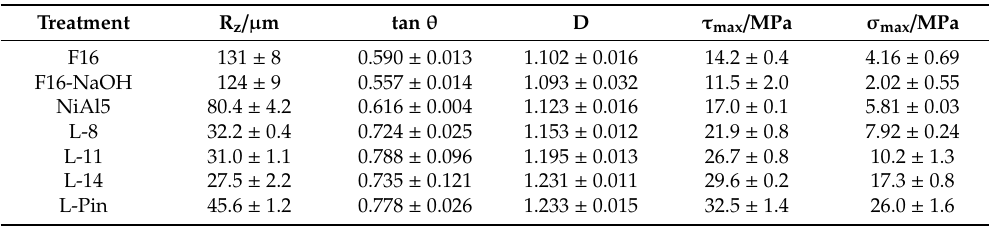
Table 2. Roughness parameters, fractal dimension, and interlaminar strength of the investigated surface structuring methods, mean values ± 1